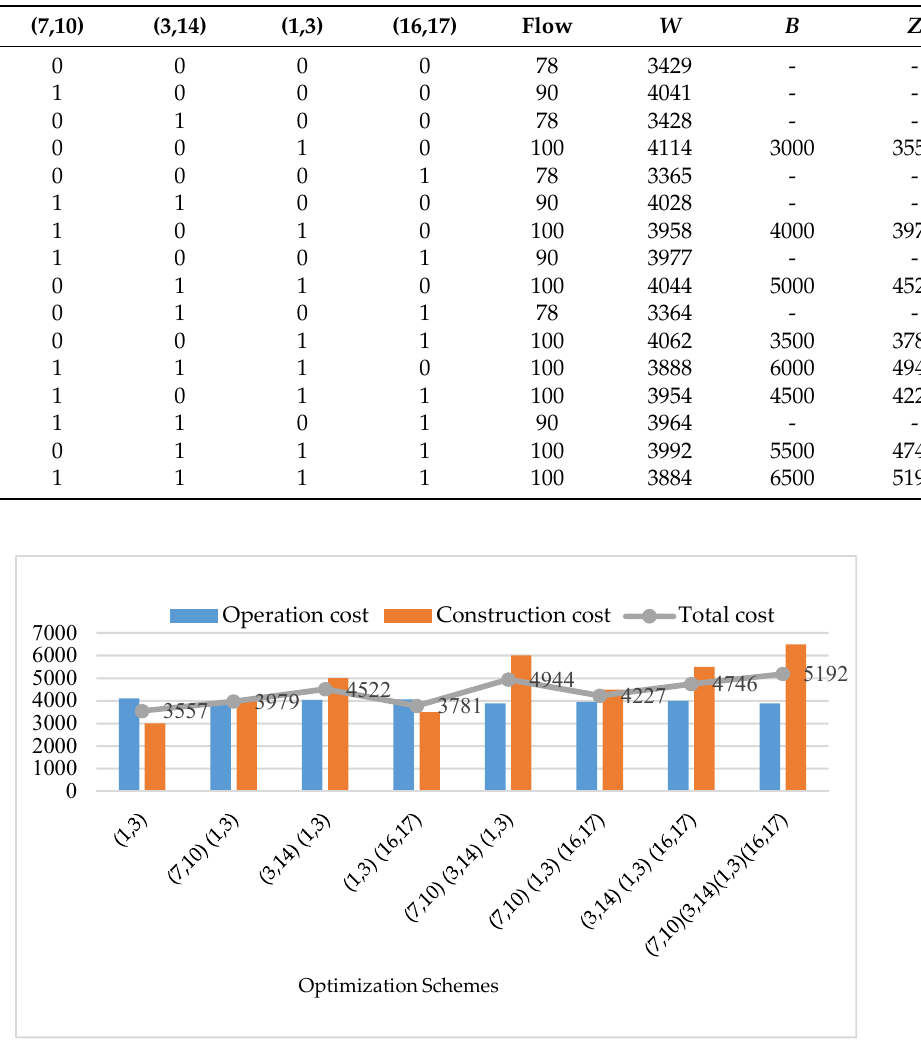
Figure 14. The optimization results of the exact algorithm.